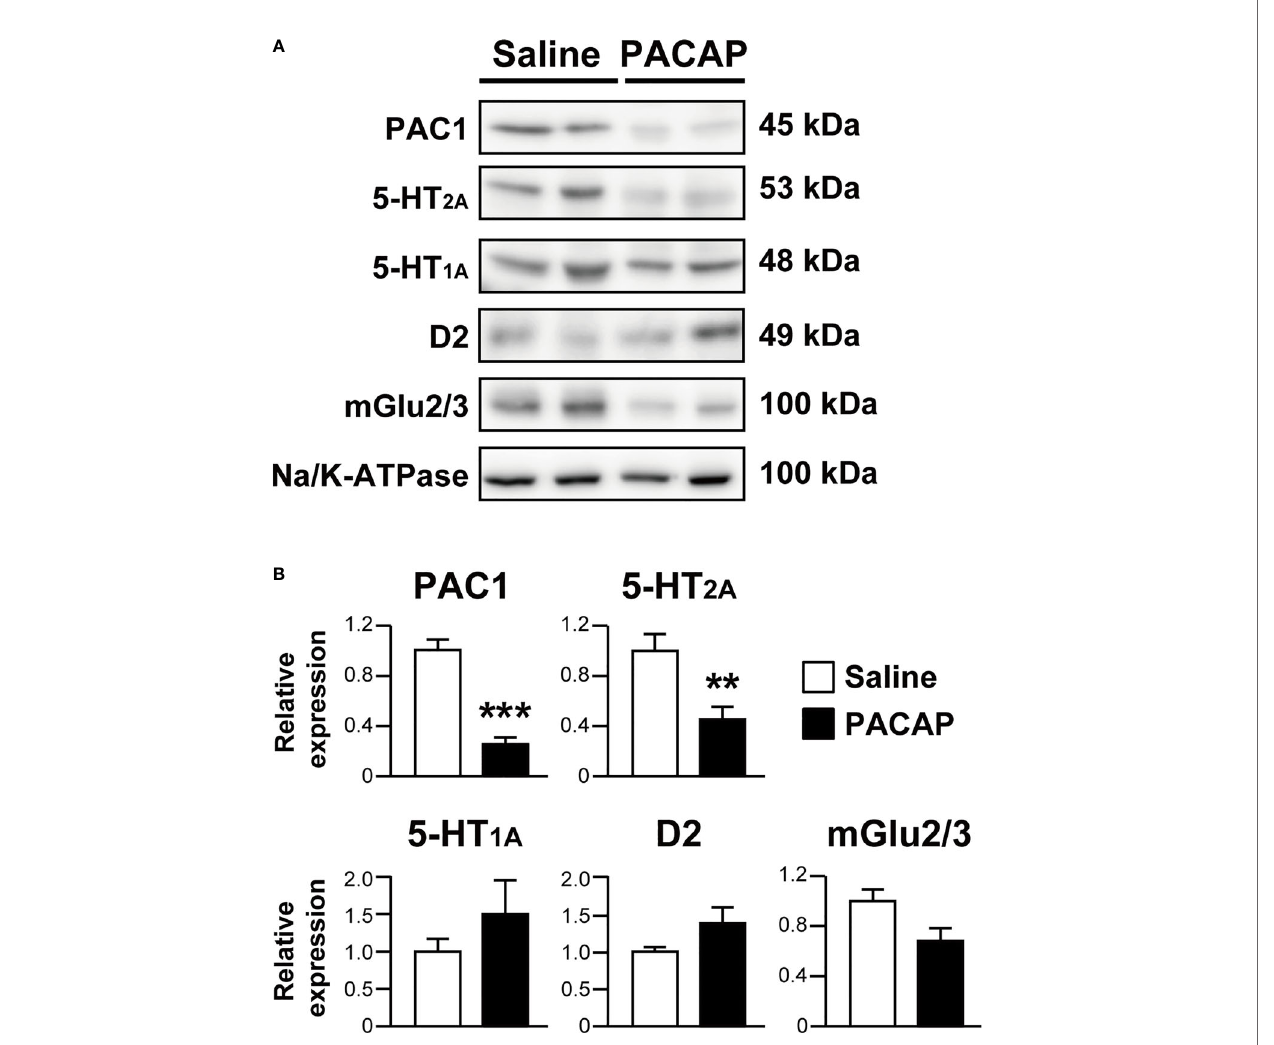
FIGURE 4 | PACAP signi fi cantly decreases cell surface localization of 5-HT 2A in primary cultured cortical neurons. (A) Representative immunoblots of cell surface biotinylated PAC1, 5-HT 2A , 5-HT 1A , D2, mGlu2/3 and alpha 1 sodium potassium ATPase (Na/K-ATPase) in primary cultured cortical neurons at 14 days in vitro treated with 1 m M PACAP or saline for 30 min. The band size is indicated for each blot. (B) Quanti fi cation of cell surface levels of PAC1, 5-HT 2A , 5-HT 1A , D2 and mGlu2/3 normalized to the levels of Na/K-ATPase. Values are the mean ± SEM from three or four independent experiments. ** p < 0.01, *** p < 0.001 vs. saline, Student ’ s t